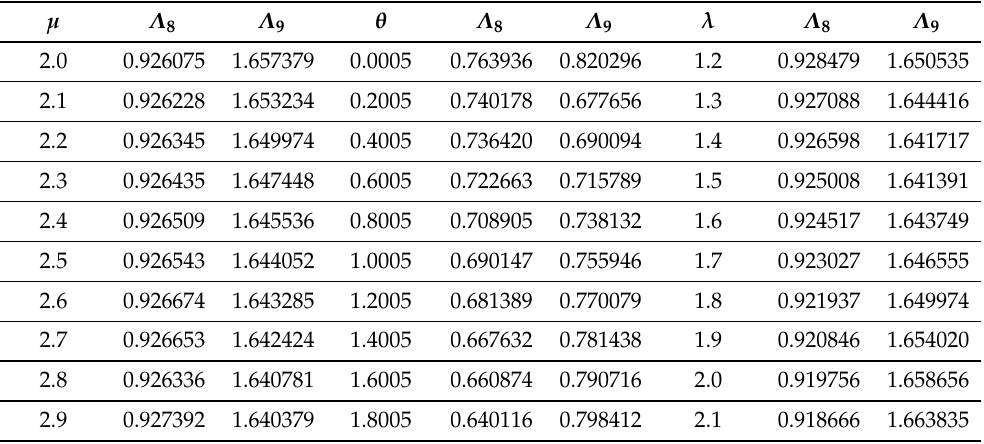
Table 9. Influence of λ , µ and θ on the fraction of successful rate of retrials and mean number of active servers for c =